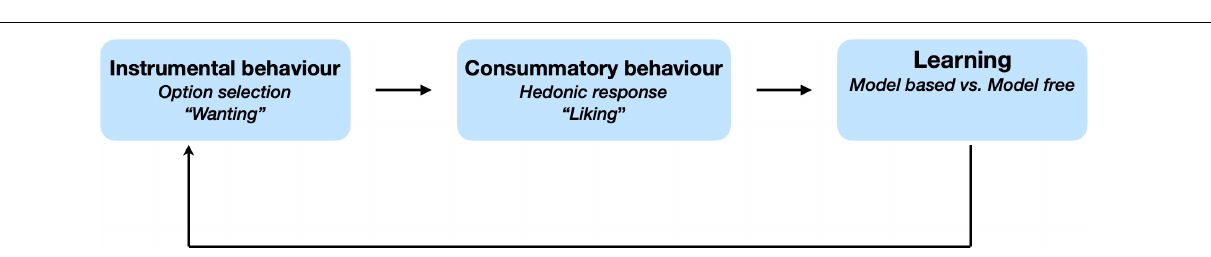
FIGURE 2 | Phases of effort-based decision making for rewards. Effort based decisions making can occur across three conceptual phases. Option selection includes the processes of weighing up components of decisions and behaviourally manifests as wanting. Consummatory phase refers to the hedonic response and represents the experience of liking. Learning reflects the process of updating beliefs based on a representation of the environment that is structured (i.e., model based) or otherwise (model free). Framework adapted from Berridge and Robinson (2003) and Husain and Roiser